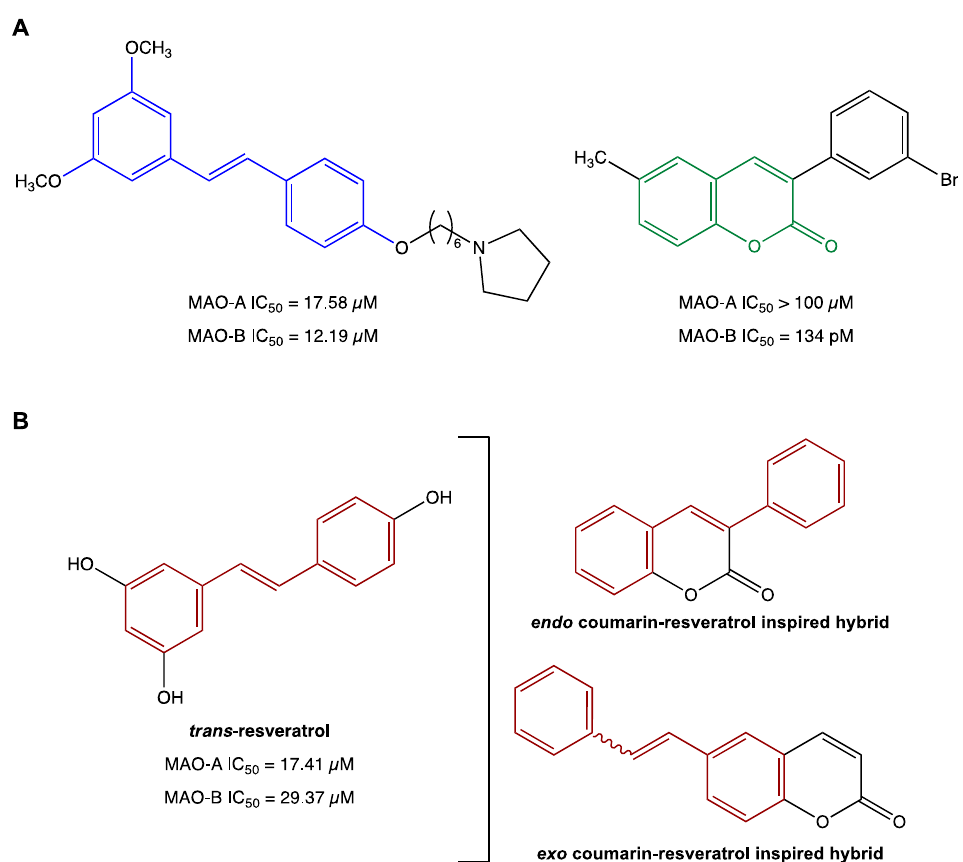
Figure 1. Rationale for the current work. ( A ) Examples of resveratrol and coumarin-inspired compounds with MAO-A and MAO-B activities. The scaffolds are highlighted in blue and green, respectively. ( B ) Chemical structure of trans -resveratrol, with MAO-A and MAO-B IC 50 values, and chemical structures of both studied coumarin-resveratrol-inspired hybrids. trans -Stilbene is highlighted in red.